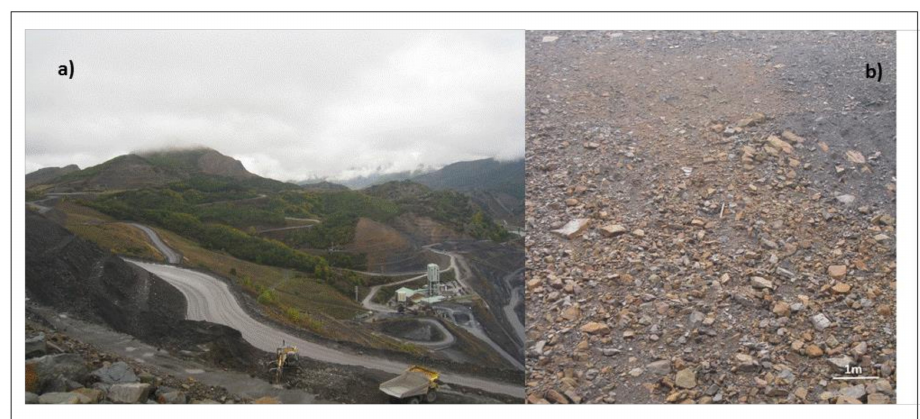
Figure 2. ( a ) General view of the mining exploitation of Santa Luc í a (Le ó n, Spain). ( b ) Detail of material from a slap